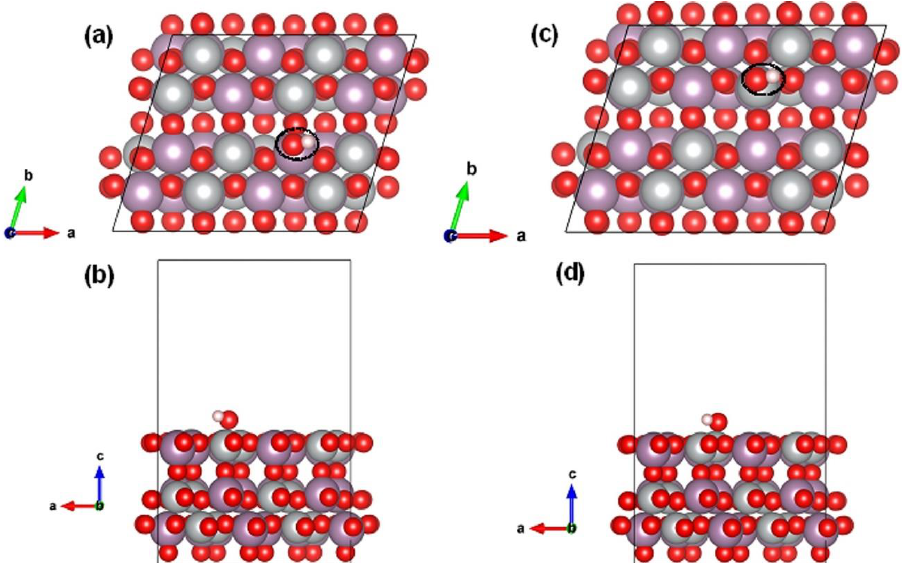
Figure 8. The optimized adsorption configurations of one HO molecule anchored on exposed ( a , b ) Mo- and ( c , d ) Ni- atoms of pristine NiMoO 4 (110) surfaces, leading to an E ads of −0.50 and −5.97 eV, respectively. The black dotted ellipsoids in ( a , c ) mark the positions of the adsorbed HO molecule on the NiMoO 4 (110) surface. In the following, the adsorption of OH adsorbed on the oxygen-deficient NiMoO 4 (110) surface was evaluated. Specifically, the adsorption on the Ni and Mo sites with lower coordination due to the removal of surface O was considered. Interestingly, it is noted that the OH group was preferred to be adsorbed at the vicinity of the oxygen-vacancy position (Figure 9a), leading to an E ads of − 3.63 eV and a charge transfer at the OH/NiMoO 4 interface (Figure 9b). This result suggests that the presence of surface oxygen vacancies offers more active sites for OH adsorption, concentration, and subsequent redox reactions for en- hanced pseudocapacitive charge storage.